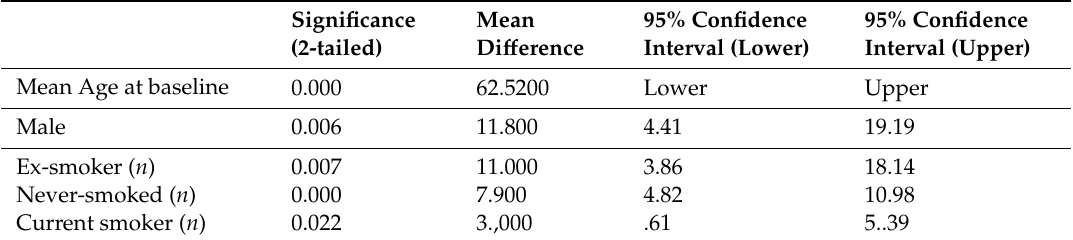
Table 2. Results of group comparison ( t -test).